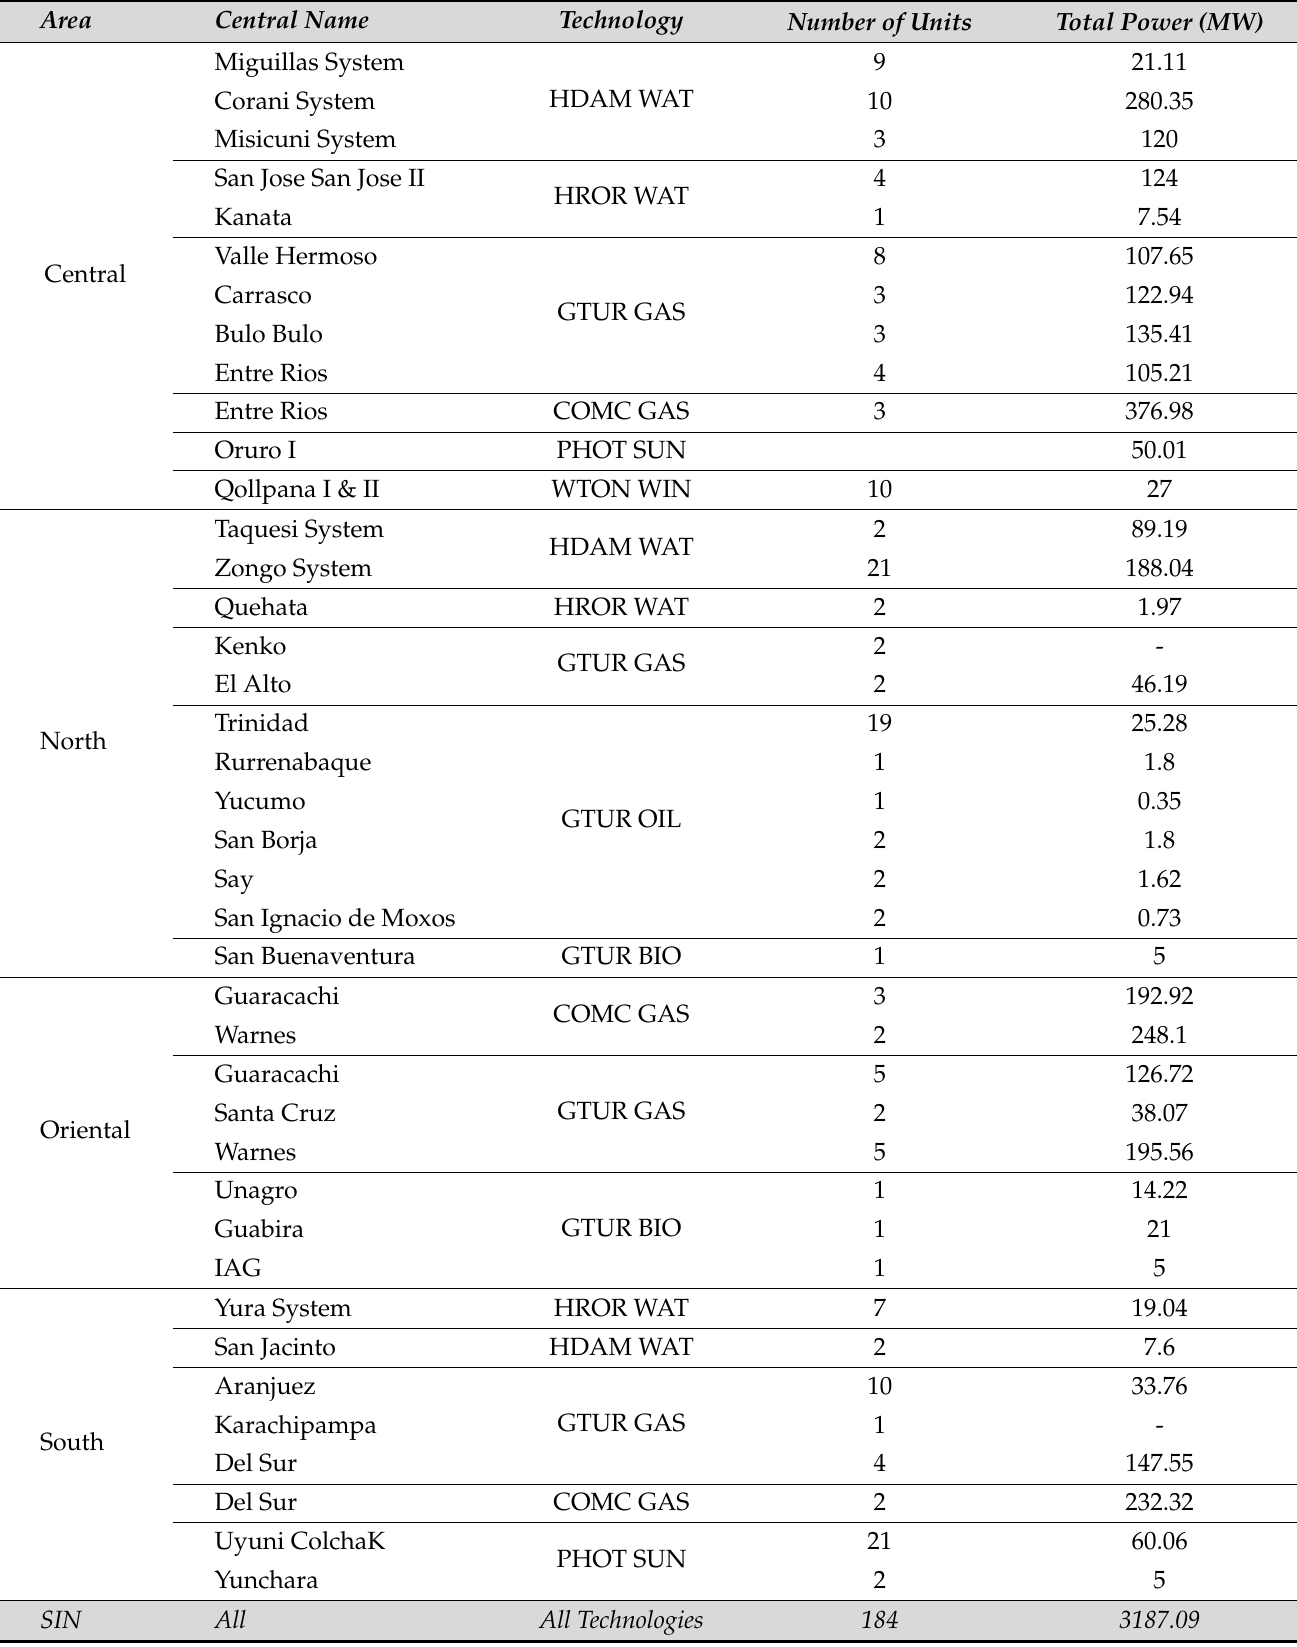
Table 2. Power generation units in 2020